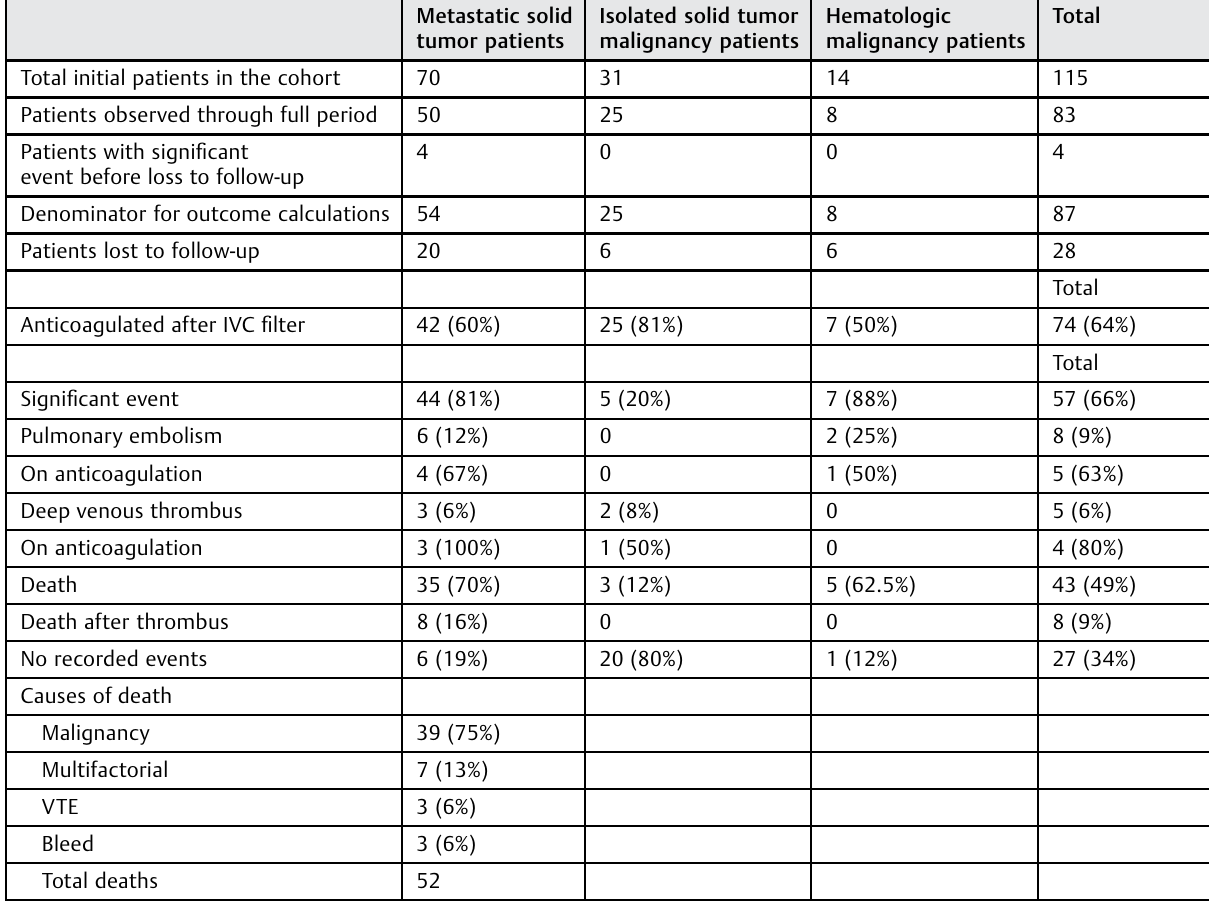
Table 3 Outcomes after IVC fi lter placement